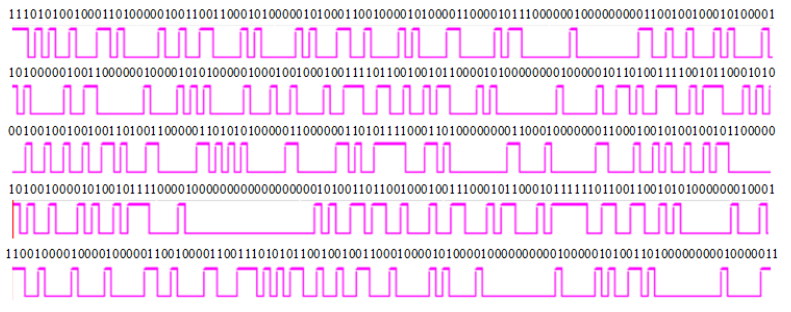
Figure 4. Restart experiment with 100 initial values captured through a logic analyser interfaced with an FPGA.